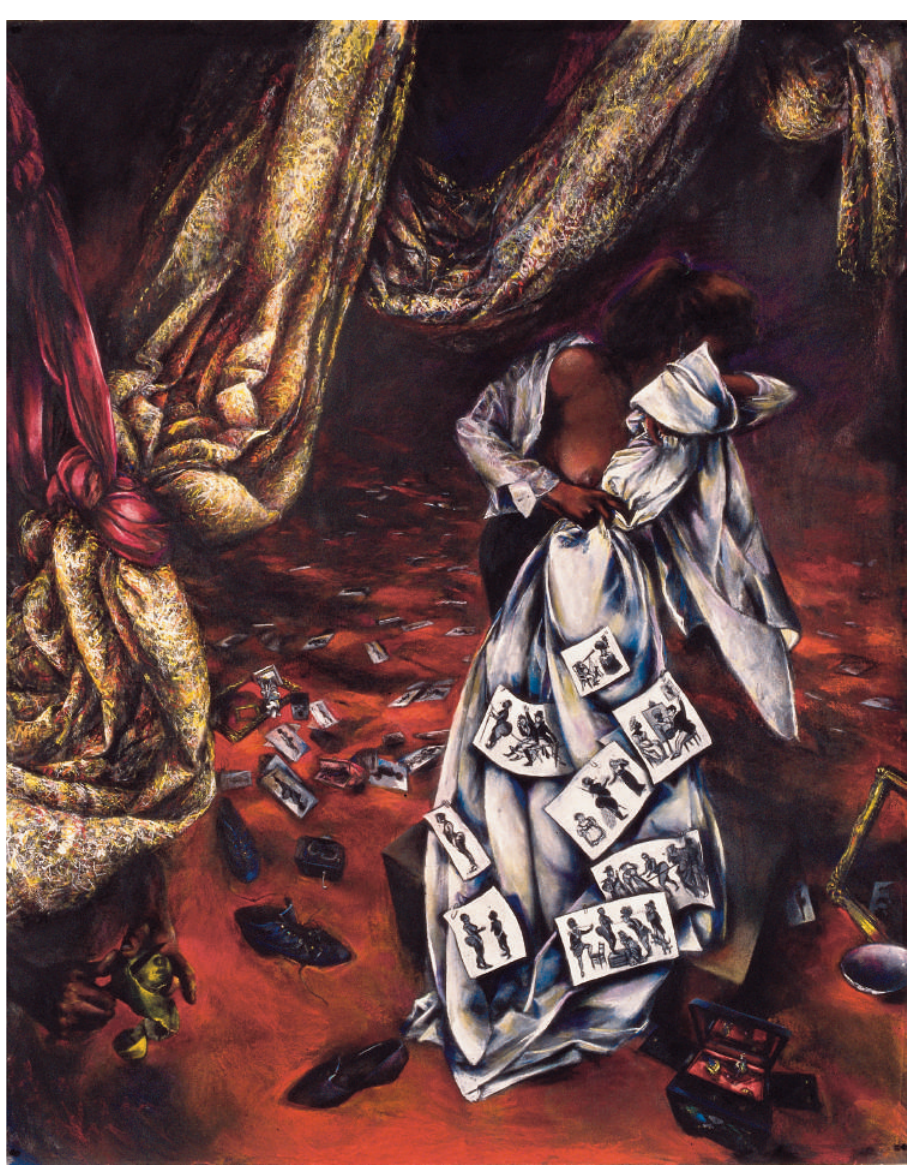
Penny Siopis, Dora and the Other Woman , 1988. Pastel on paper, 153x 120 cm. Private collection, Johannesburg (photo: courtesy Penny Siopis and Stevenson Gallery, Cape